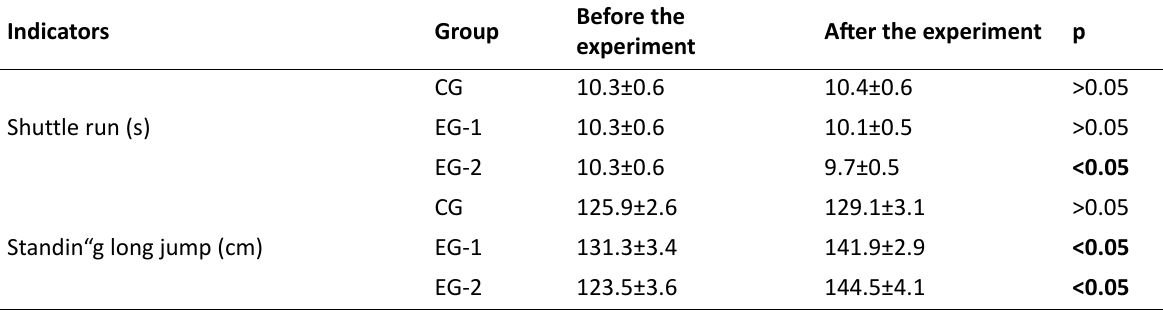
Table 1. Indicators of coordination and speed-power qualities of schoolchildren of 7-8 years old (M ± m)